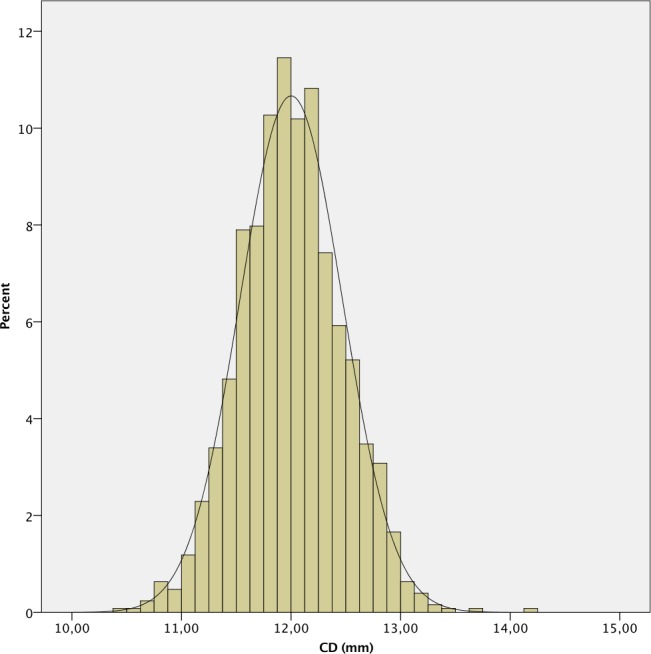
Histogram of corneal diameter (CD) of the study population.